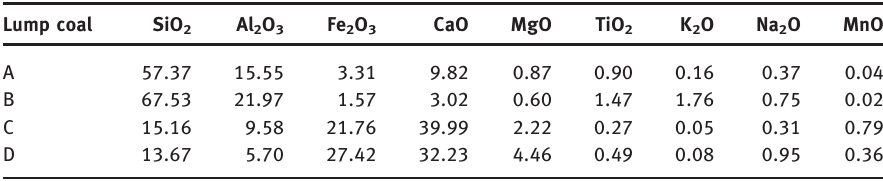
Table 2: Chemical compositions of the coal ash, mass %. Lump coal